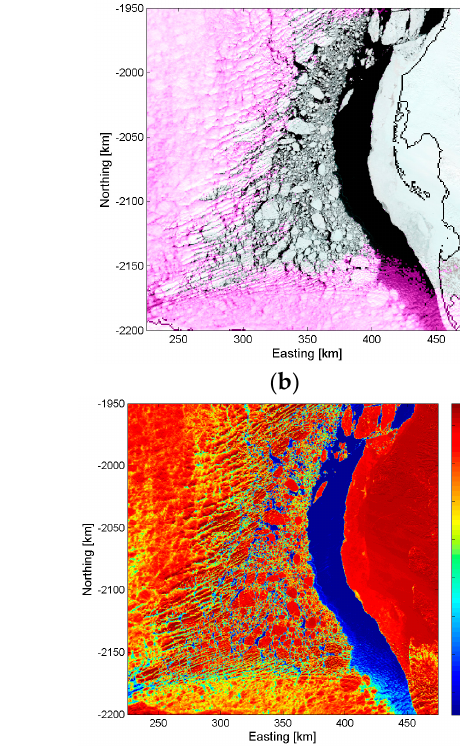
Figure 13. MODIS open water–sea ice classification charts for the images (a) and (c) in Figure 12. ( a ) Chart with the original MOD35 cloud mask; and ( b ) chart with the cloud mask developed here.